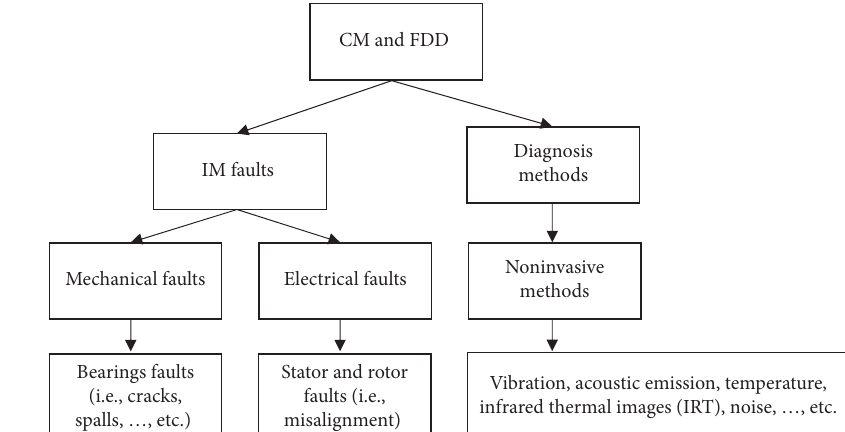
Figure 4: CM and FDD techniques of IM.